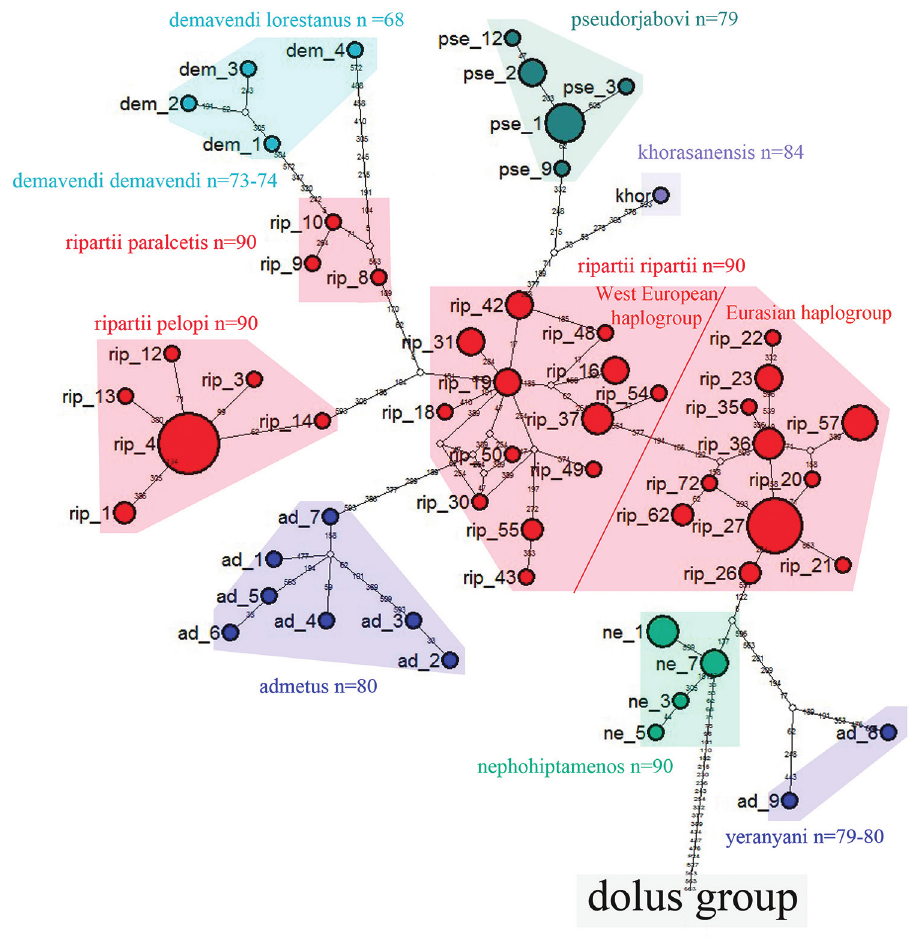
Figure 10. Haplotype network of P. admetus species group. Colored circles represent different taxa. Each line segment represents a mutation step, and white small circles represent “missing”